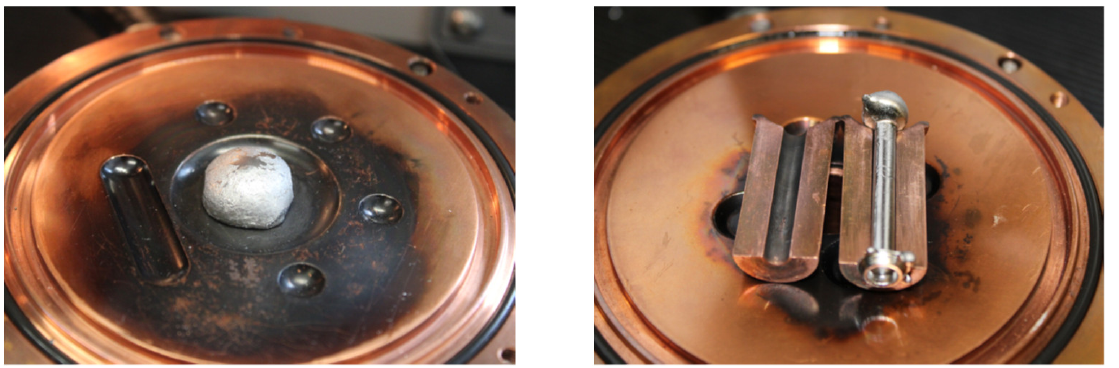
Figure 6. Melted samples in the arc furnace and cast rod where dilatometric samples are produced by lathe machining. In total, 6 samples are taken out of one melted-material combination.